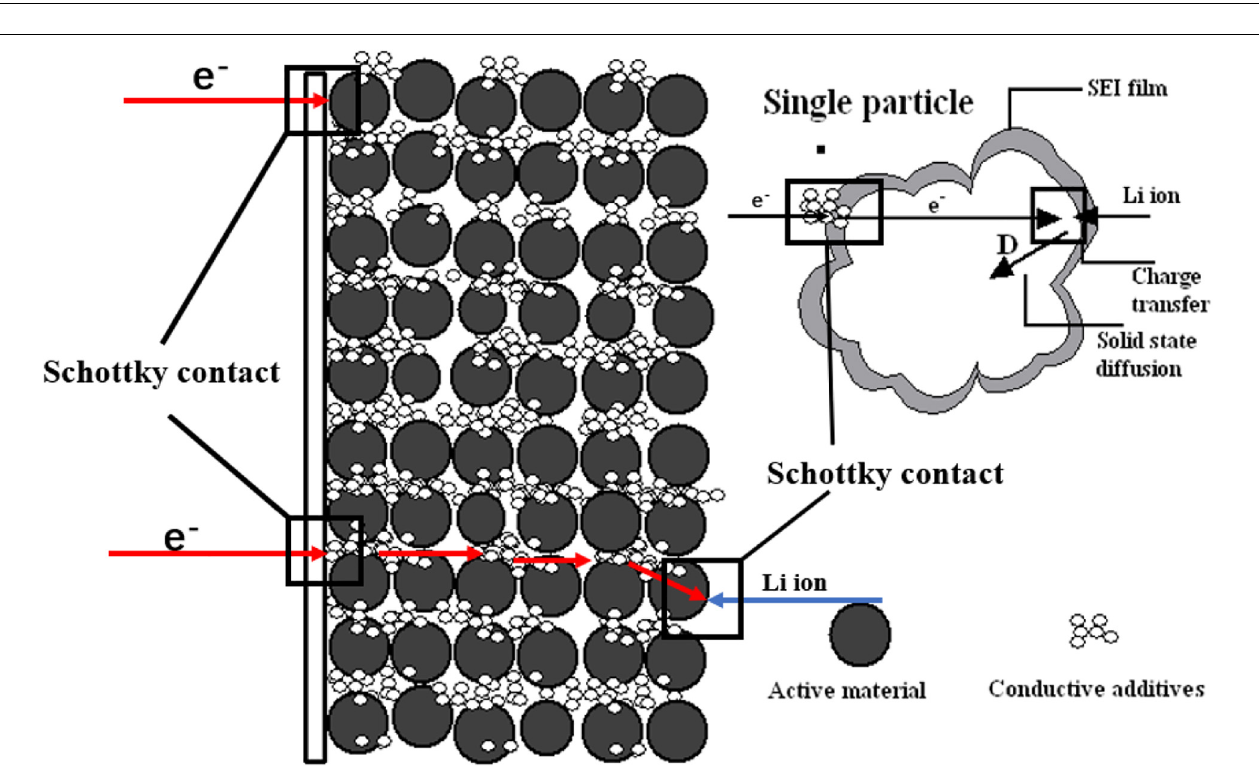
FIGURE 4 | Model schematic diagram of the physical mechanism of the lithium intercalation process. Reproduced with permission from Ref. Zhuang et al. (2010). Copyright 2010 American Chemical